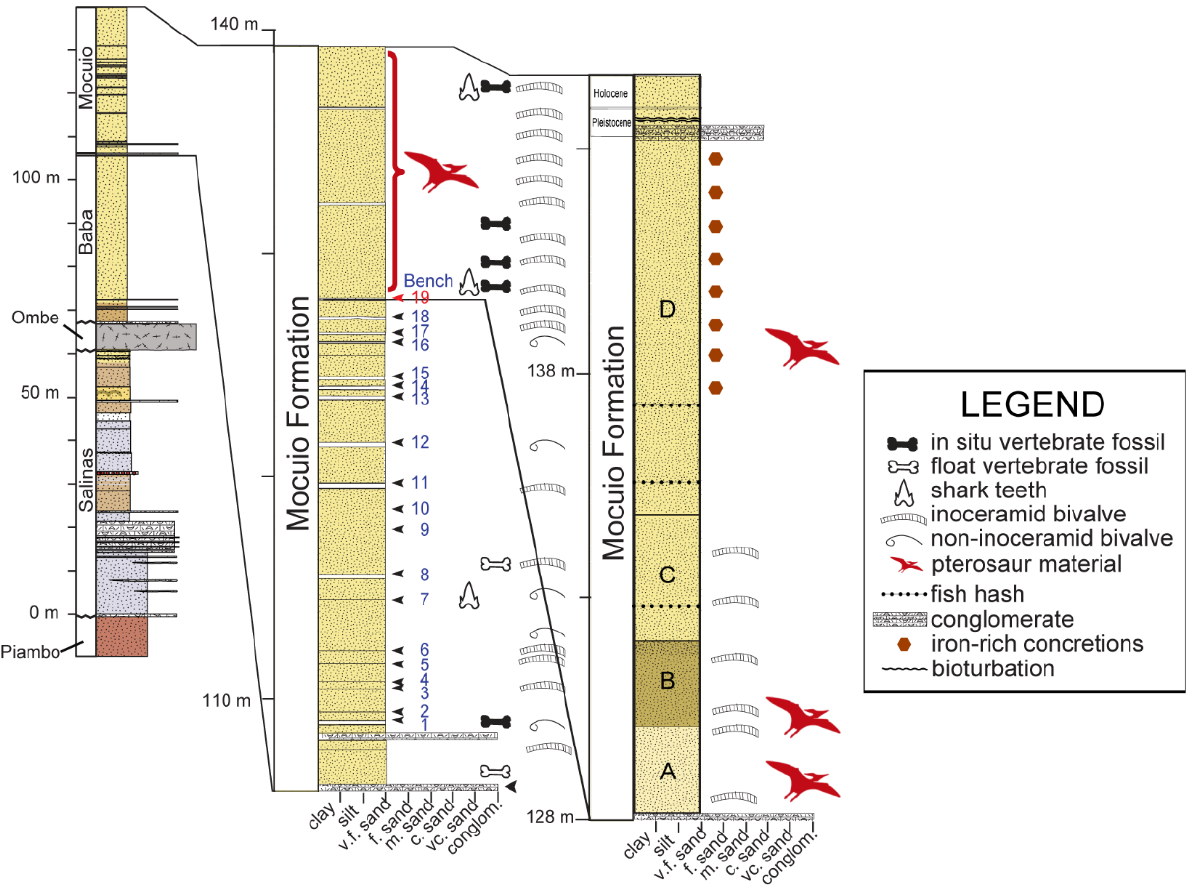
Figure 2. Stratigraphic section of the Bentiaba locality . Strata yielding pterosaur fossils are demar- cated (modified from Strganac et al. 2014 [26]).